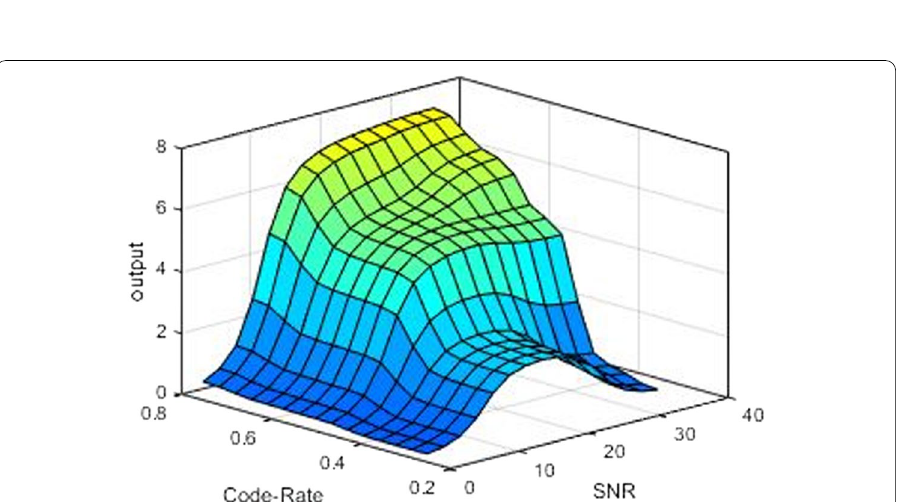
Fig. 23 ANFIS surface view for SNR versus Code-Rate. This figure shows the 3D ANFIS surface views of the signal-to-noise ratio and coding rate combination result. The upper yellow surface indicates a better data rate resulted from a high SNR value at higher coding rate. The surface with blue color indicates a low data rate resulted from a low order modulation schemes for various target